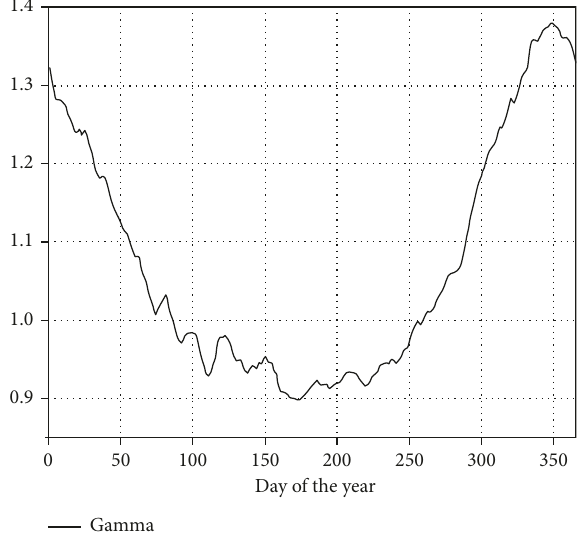
Figure 2: β fluctuates around a fixed value (gamma